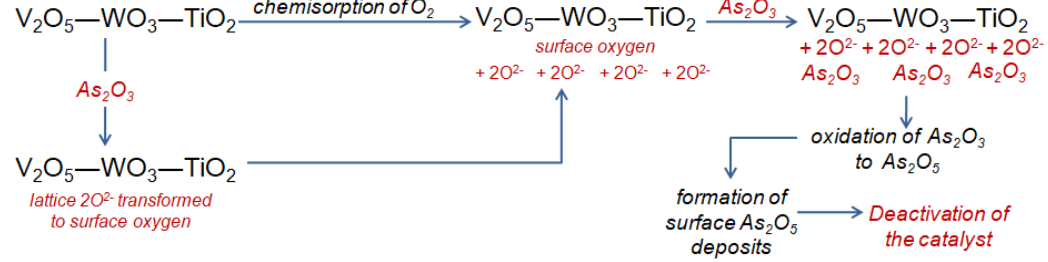
Figure 4. Deactivation of V 2 O 5 -TiO 2 by arsenic species (scheme based on Reference [32]).